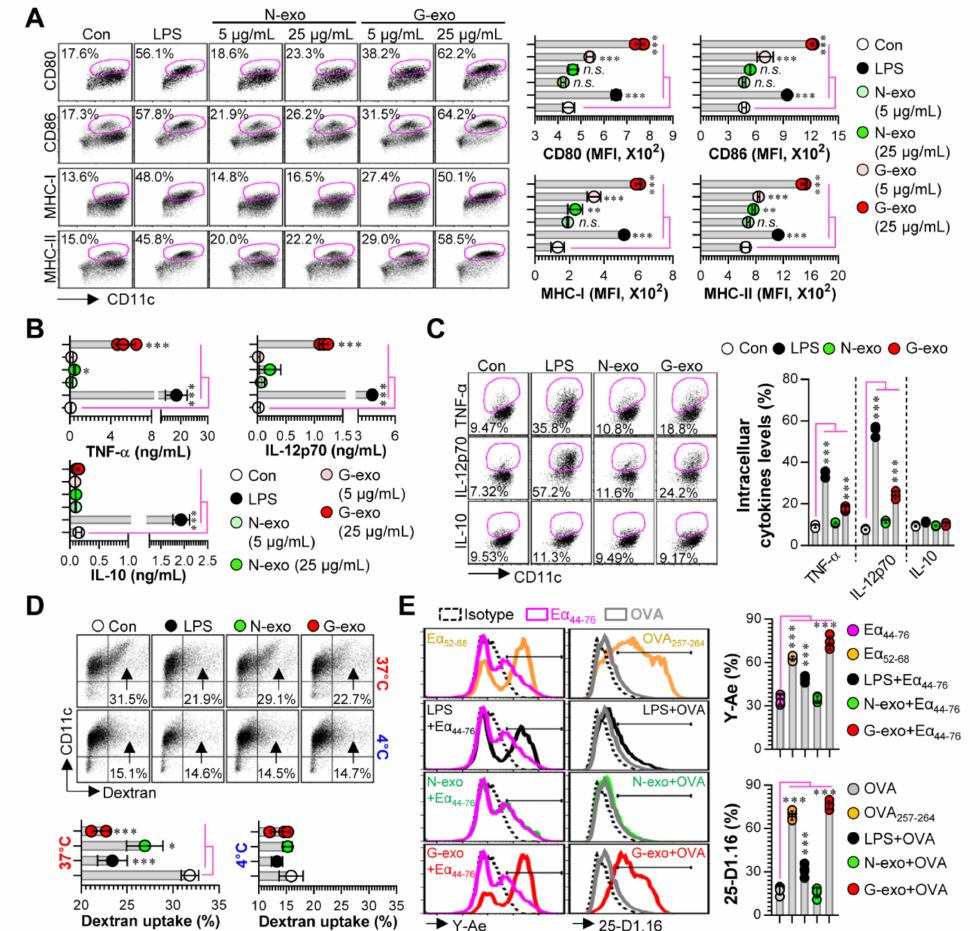
Figure 2. Analysis of surface molecules, cytokine production, antigen-uptake and presenting ability in N-exo- and G-exo-stimulated DCs. ( A , B ) BMDCs were stimulated with LPS (100 ng / mL), N-exo (5 and 25 µ g / mL) and G-exo (5 and 25 µ g / mL) for 18 h ( n = 3). ( A ) The expression of surface molecules such as CD80, CD86, MHC-I, and MHC-II were analyzed using flow cytometry via their respective Ab staining. ( B ) TNF- α , IL-12p70, and IL-10 production were measured in culture supernatants via ELISA. ( C ) BMDCs were stimulated with N-exo (25 µ g / mL) and G-exo (25 µ g / mL) for 18 h in the presence of GolgiPlug, stained with anti-CD11c Ab, and were fixed / permeabilized. Cells were stained with anti-TNF- α , -IL-12p70, and -IL-10 Abs; the presence of the TNF- α + CD11c + , IL-12p70 + CD11c + , and IL-10 + CD11c + cytokines were detected via flow cytometry ( n = 3). ( D ) BMDCs were stimulated with N-exo (25 µ g / mL) and G-exo (25 µ g / mL) at 37 ◦ C (positive condition) and 4 ◦ C (negative condition). After 18 h, the cells were treated with Dextran-FITC for 30 min and analyzed for Dextran-FITC uptake levels (CD11c + Dextran + cells indicate having an antigen-uptake ability) by flow cytometry ( n = 3). ( E ) BMDCs were stimulated with LPS (100 ng / mL), N-exo (25 µ g / mL), and G-exo (25 µ g / mL) in the presence of OVA protein or E α 44–75 for 18 h and stained with anti-CD11c, -Y-Ae (in the E α 44–75 treatment condition), or -25-D1.16 (in the OVA treatment condition) Abs, and expression levels of E α 44–75 / I-Ab and OVA 257–264 / H-2Kb complexes were analyzed in CD11c + cells using flow cytometry ( n = 4). E α 44–75 - and OVA 257–264 -treated cells are positive control for MHC complexes. * p < 0.05, ** p < 0.01, *** p < 0.001. n.s .: not